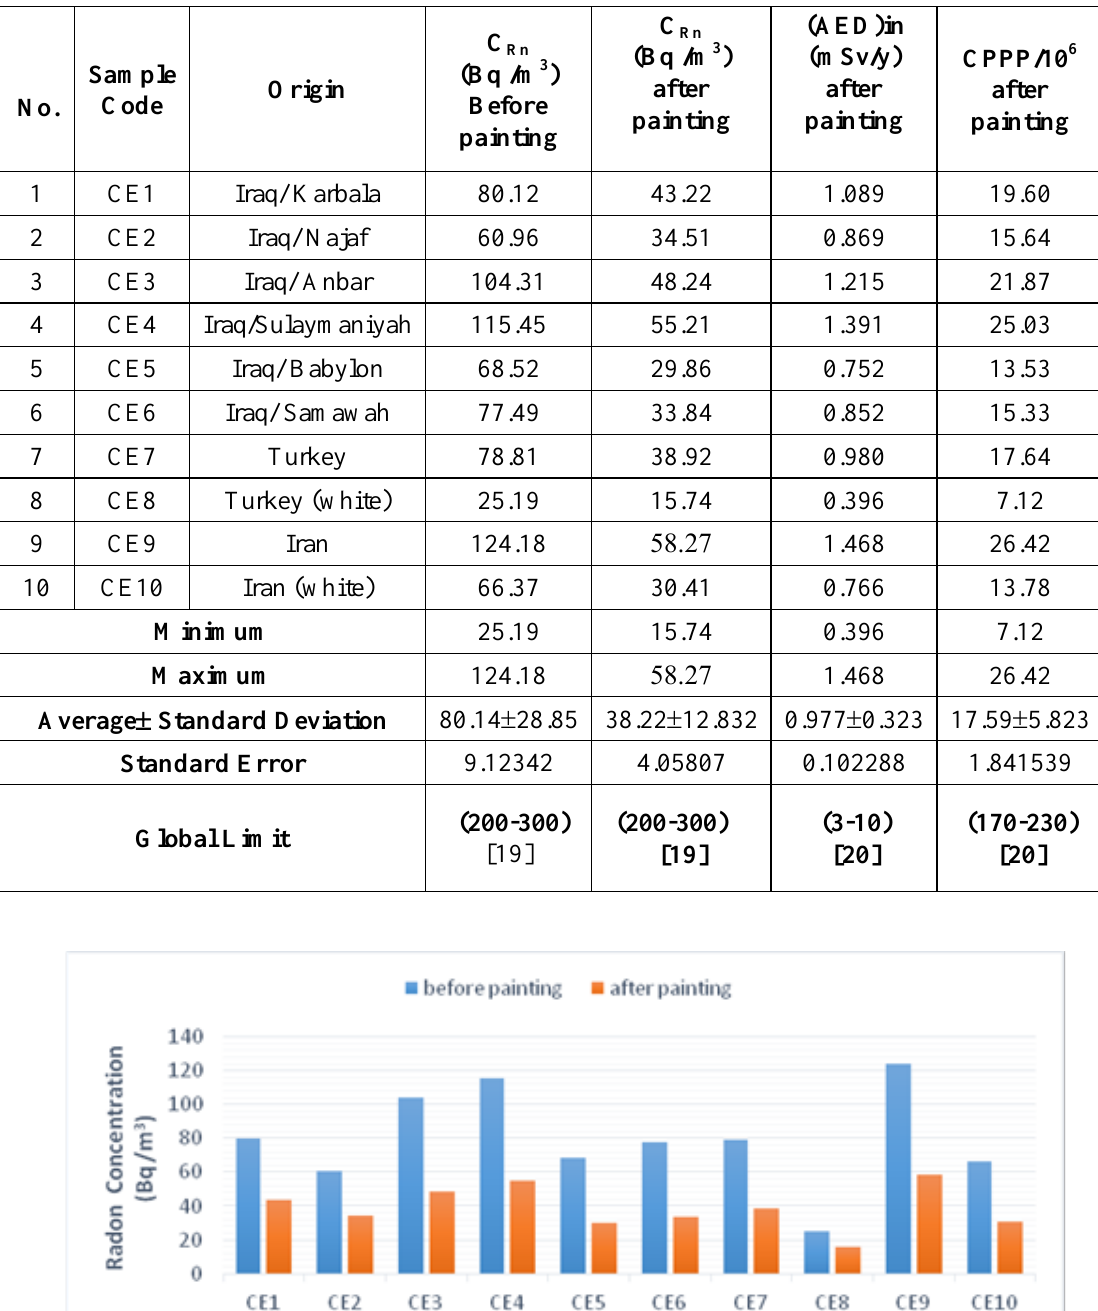
Table 2: The concentrations of (C